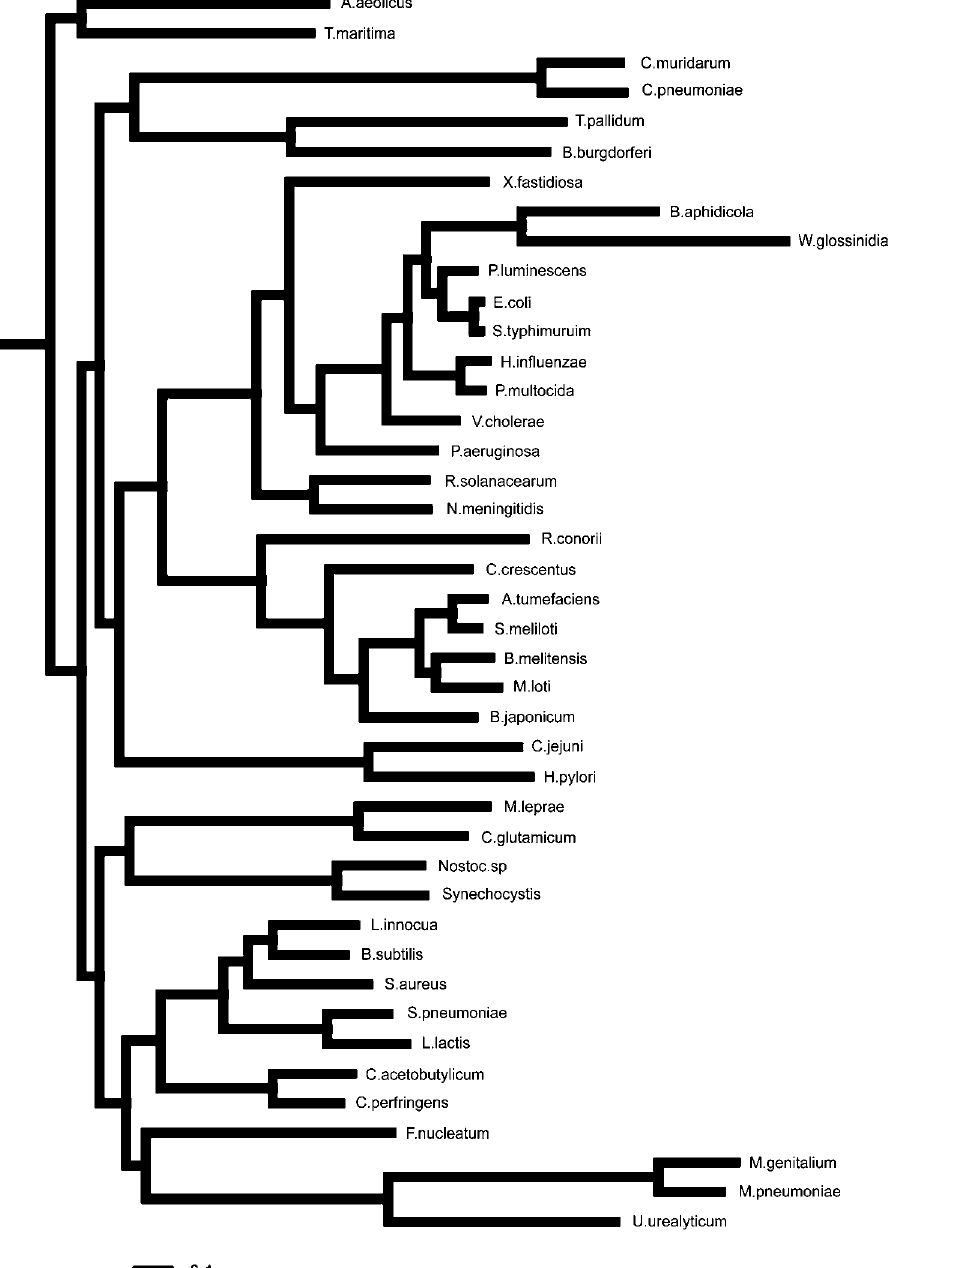
Figure 2. Phylogeny of the 42 bacterial species analyzed. Phylogeny based on a set of 51 genes present in single copy in most bacterial genomes. Concatenated multiple sequence alignments were used as input for the bayesian tree reconstruction program MrBayes [50]. The tree topology and branch lengths shown correspond to the most likely tree obtained in two independent runs of MrBayes spanning 250,000 generations each. All clades were recovered with 100% posterior probability. The tree is rooted on the branch leading to the hyperthermophiles Aquifex aeolicus and Thermotoga maritima .